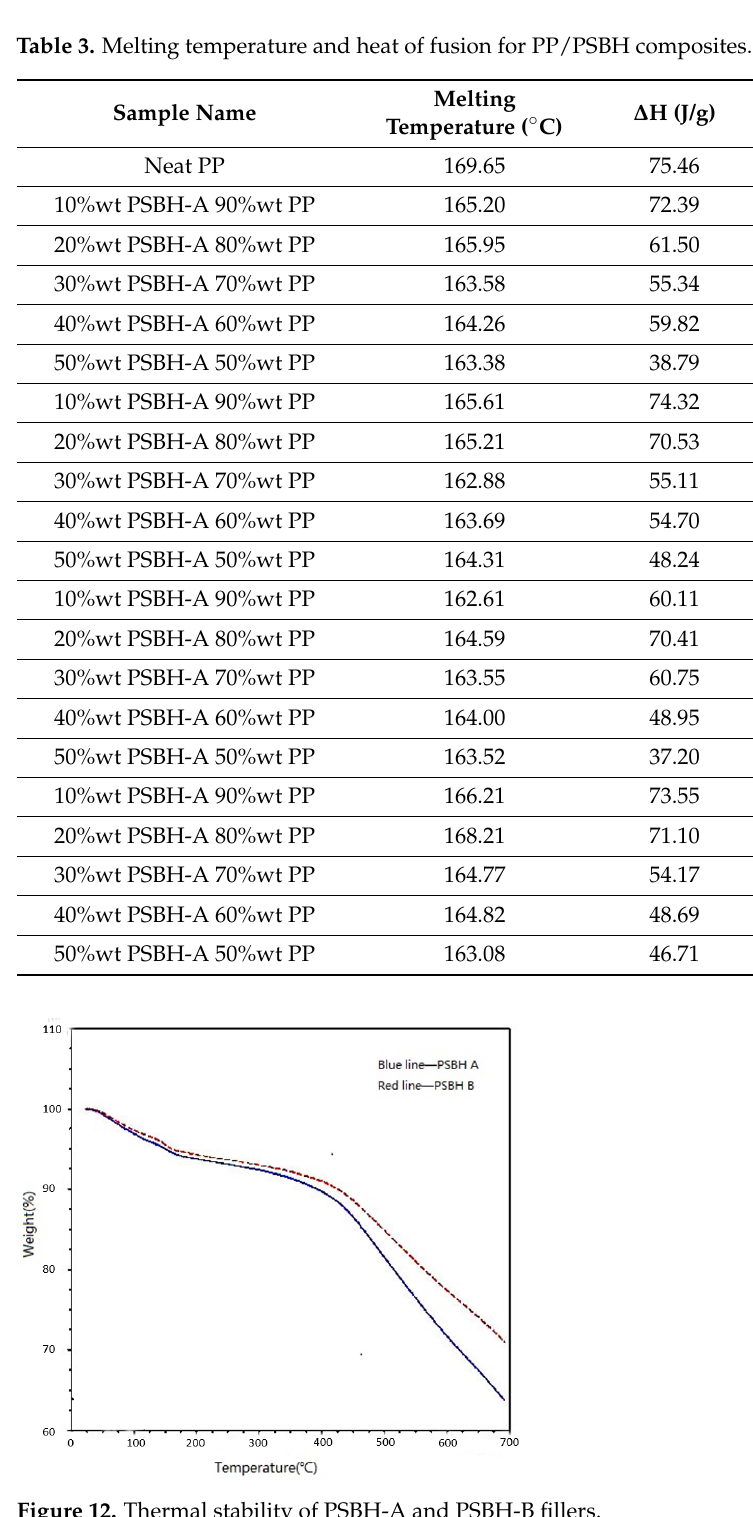
Figure 12. Thermal stability of PSBH-A and PSBH-B